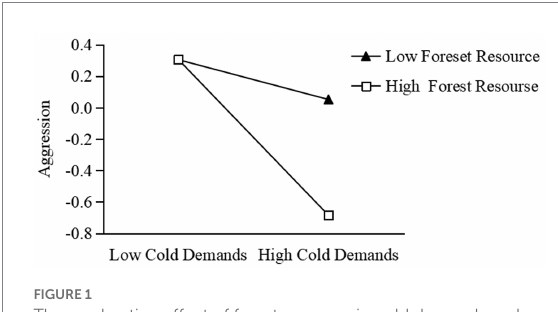
FIGURE 1 The moderating effect of forest resource in cold demands and aggression.